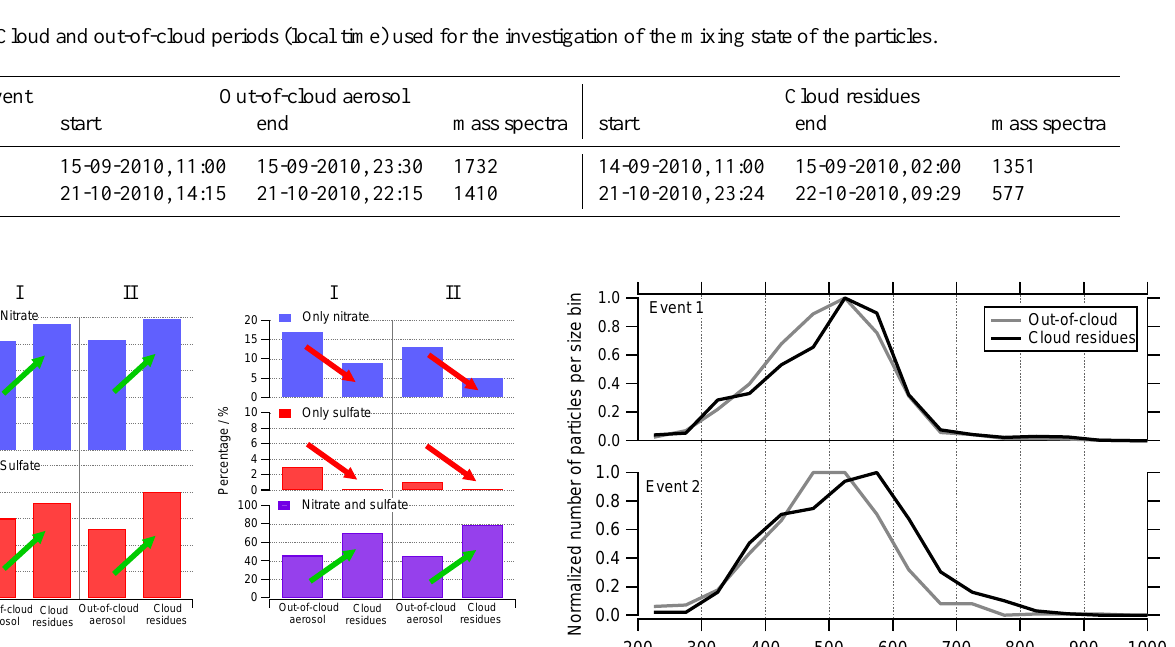
Figure 11. Indications for a change of the mixing state of the par- ticles in the cloud (for details of event I and II see Table 5). Left: percentage of out-of-cloud aerosol particles and cloud residues con- taining either nitrate (blue) or sulfate (red). Right: particles con- taining only nitrate but no sulfate (blue), only sulfate but no nitrate (red), and particles containing both nitrate and sulfate (purple).